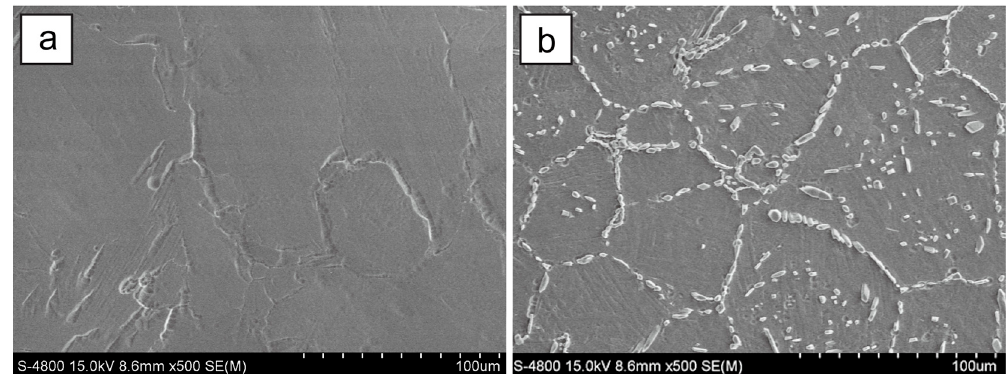
Figure 12. The SEM images of TMCs modified and reinforced with 0.6 wt % inoculants and